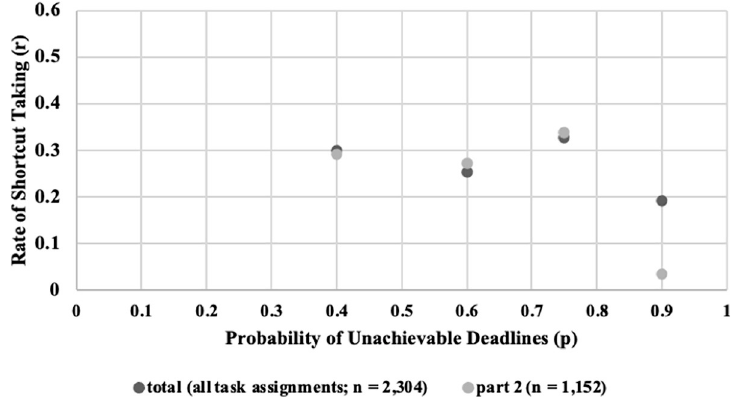
Fig 5. Relation between probability of unrealistic deadlines (p) and rate of shortcut taking (r).